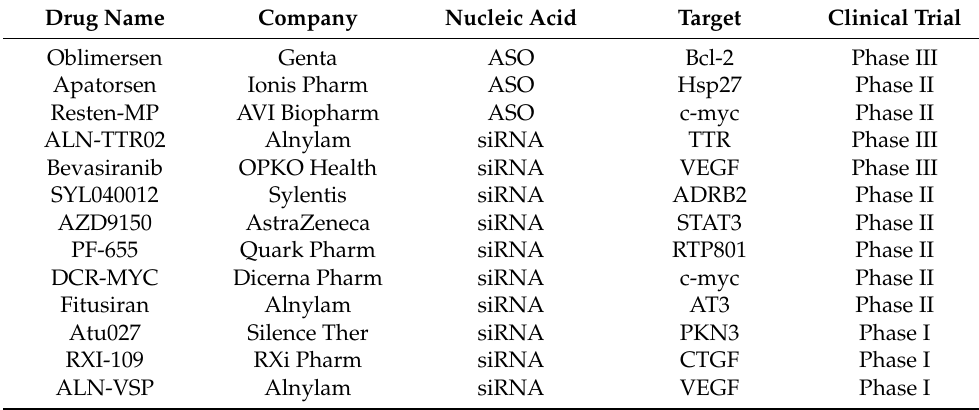
Table 1. Representative nucleic acid-based therapeutics targeting ASOs, siRNAs and miRNAs under clinical